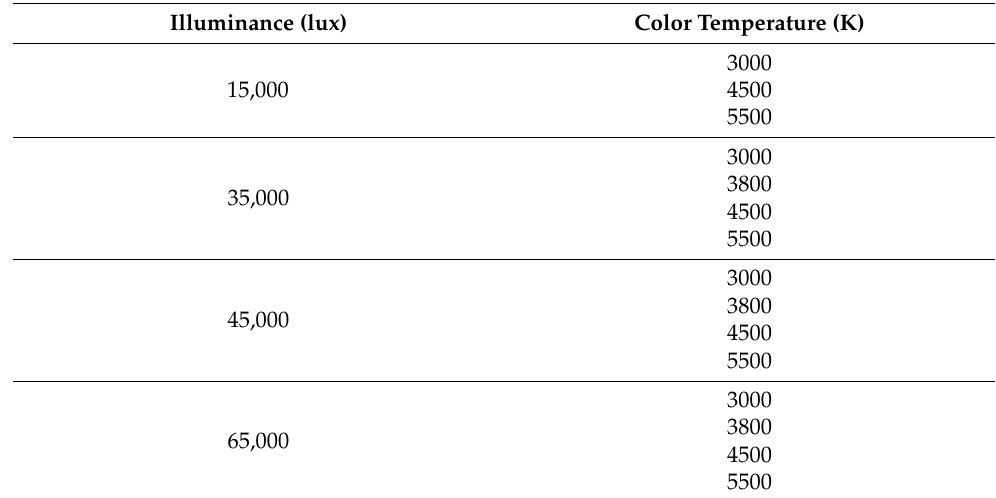
* “O” represents the direct sunlight condition, whereas “X” represents the shaded condition. Table 2. Lighting conditions for digital soil image